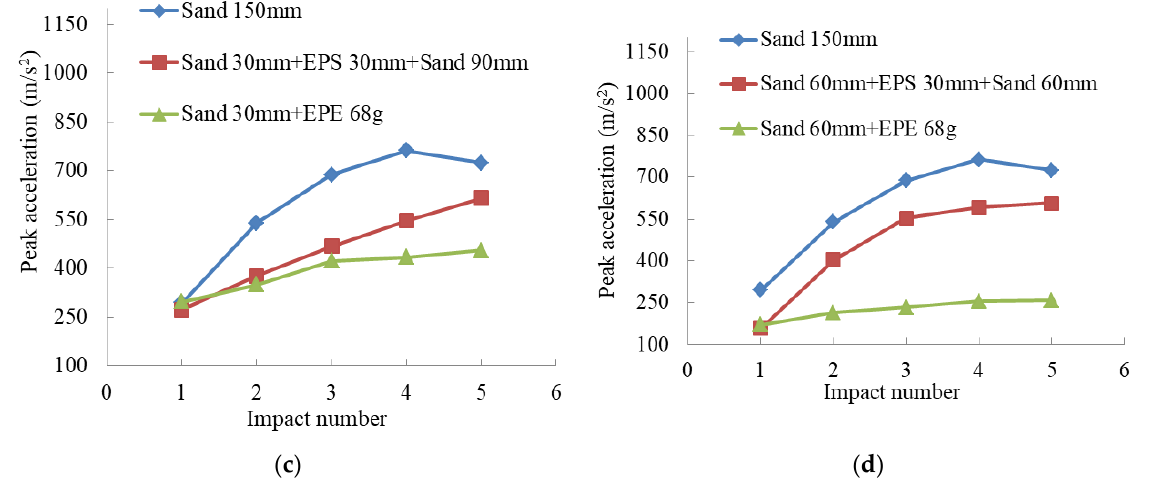
Figure 16. Variation curves of the acceleration with the impact number for different geofoam types.